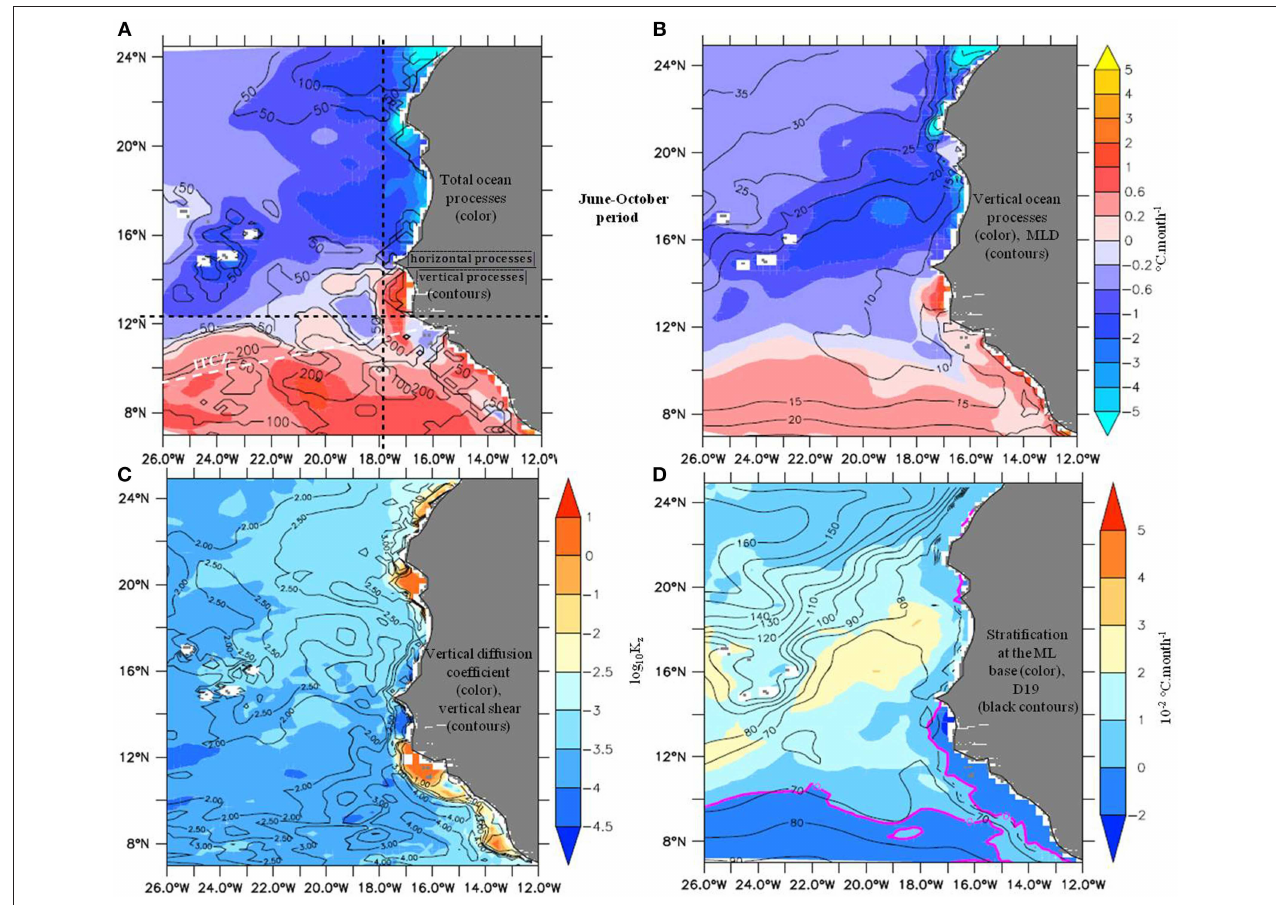
FIGURE 11 | Same as in Figure 7 but over WP